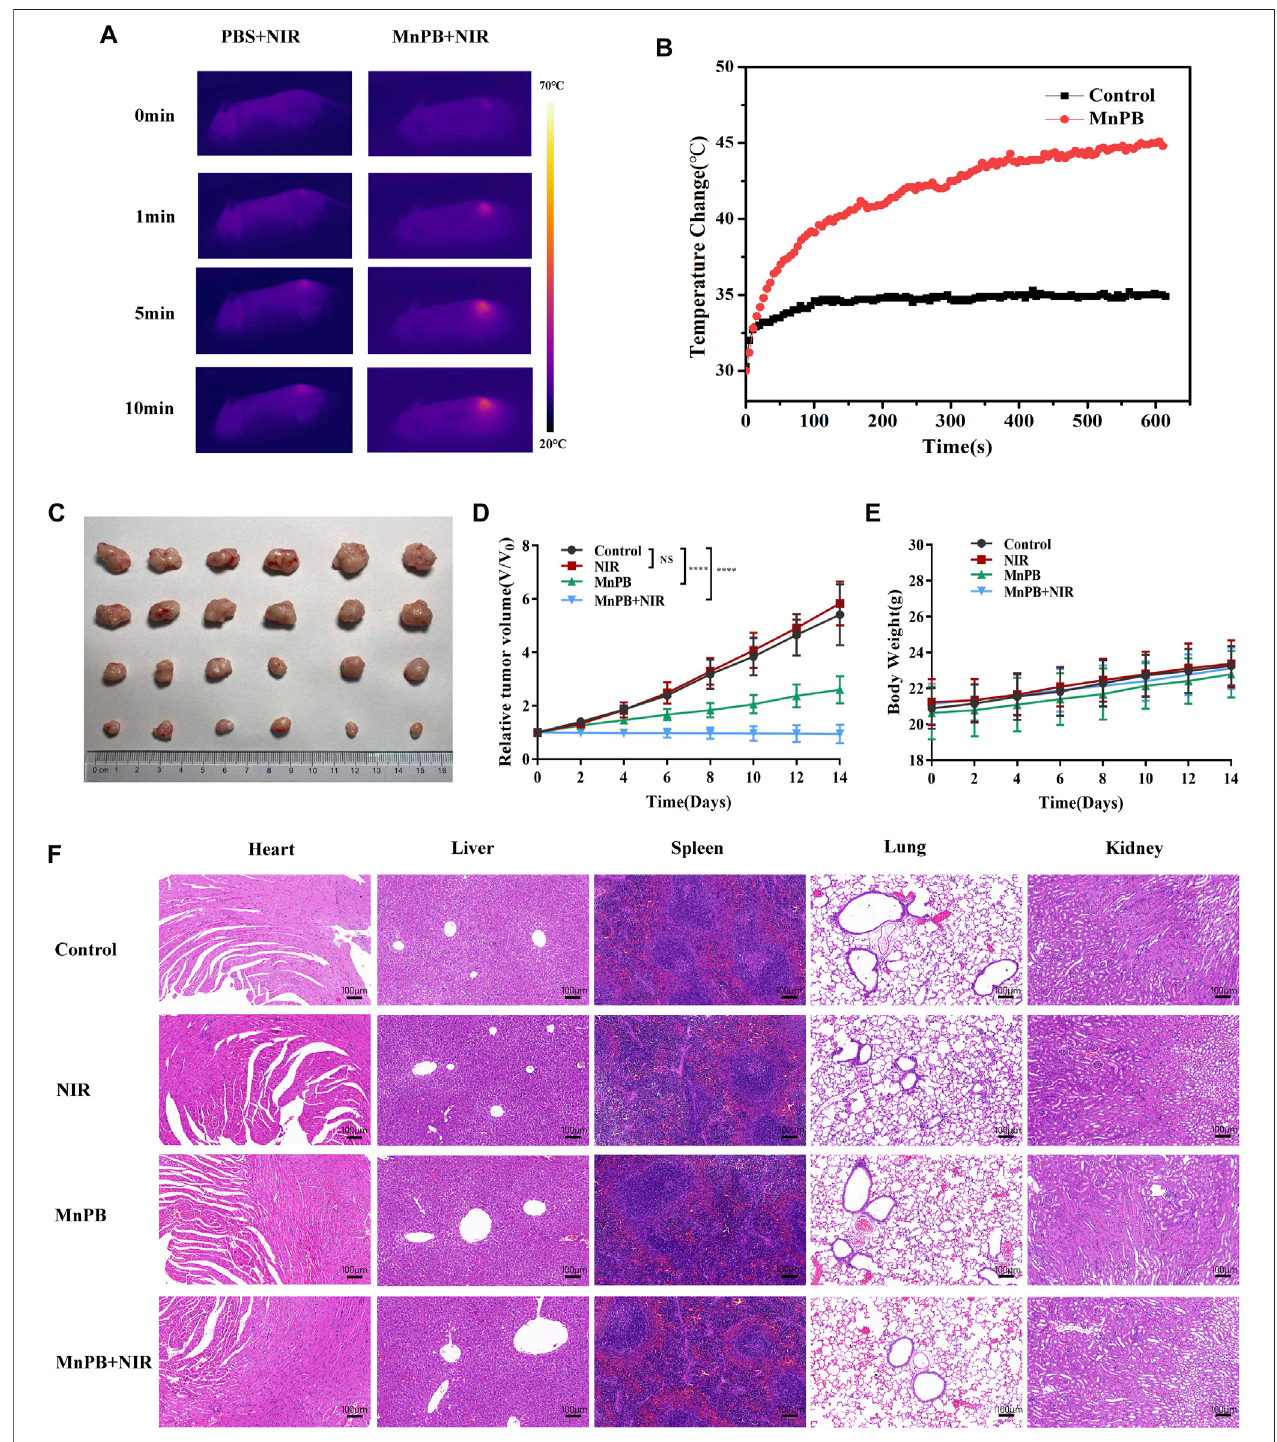
FIGURE 7 | The MnPB NPs inhibit the growth of tumor xenografts in nude mice. (A) Pictures recorded by a thermal imaging camera during NIR irradiation. (B) Temperature curve of tumor areas in mice. (C) The tumor picture taken at day 14. (D) Relative tumor volume curve and (E) body weight curve of mice with various treatments. (F) H&E staining of main organs from mice in different groups. Scale bar, 100 μ m.